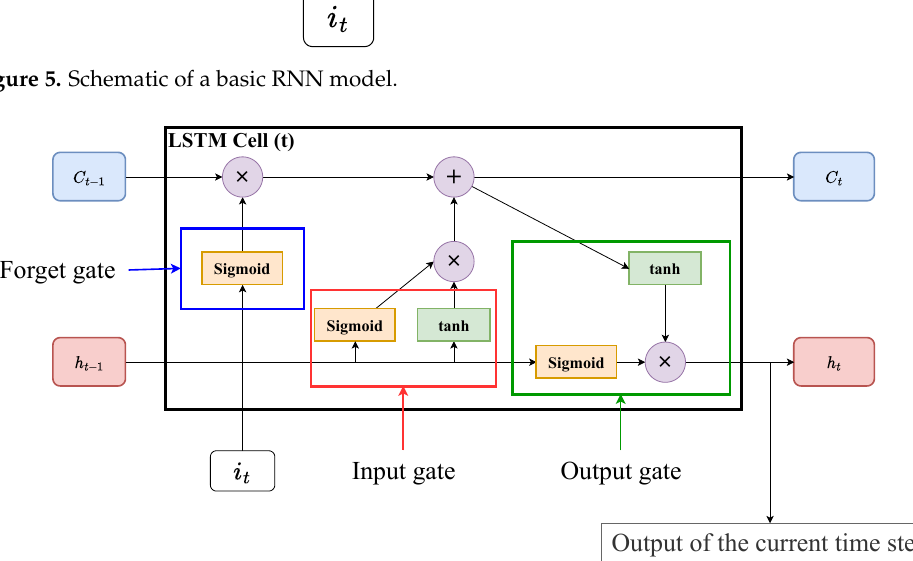
Figure 6. Schematic of an LSTM